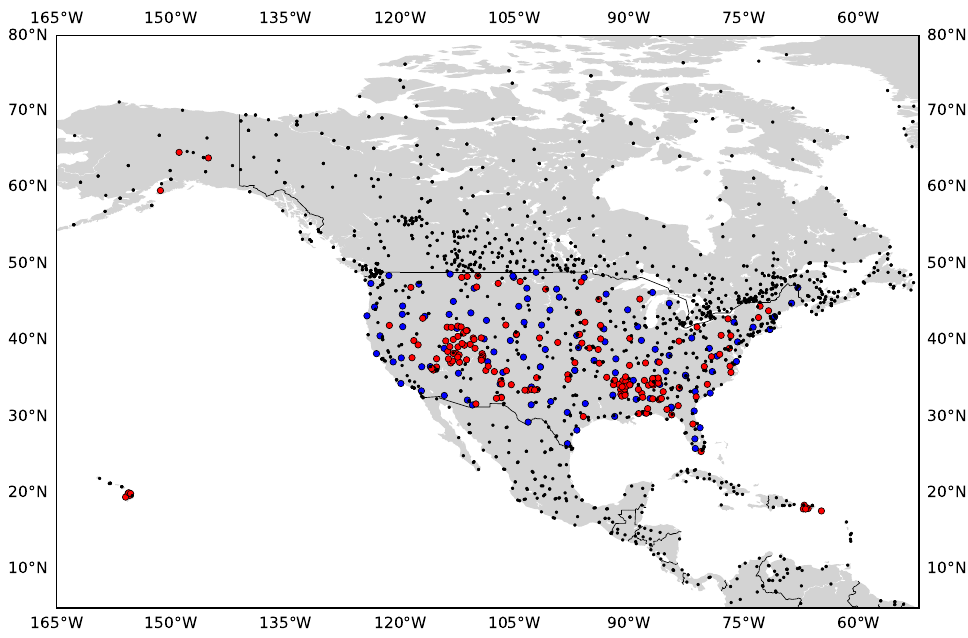
Figure 1. Region under study. Overlapped are the observations from the SYNOP network (black dots), and the ground soil moisture observations from the SCAN (red circles) and USCRN (blue circles) networks in the